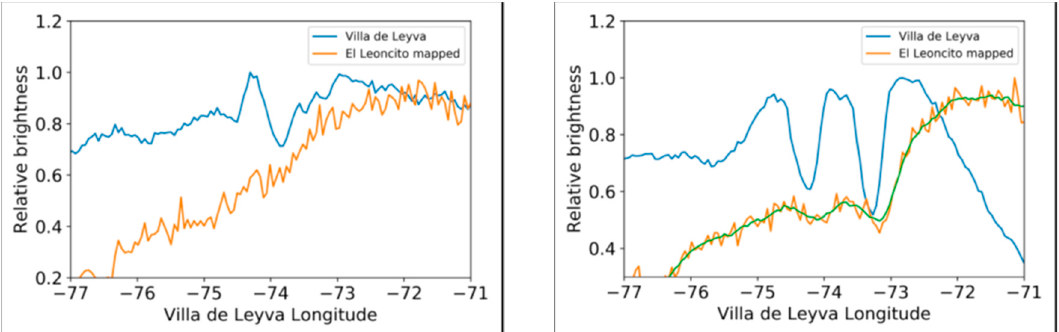
Figure 12. ( left ) Blue line represents the normalized brightness obtained from the cut at 9° N over the Villa de Leyva imager. The orange line is the brightness from the conjugate line at El Leoncito (the top red curve on the right image from Figure 11) mapped along magnetic field lines to the Villa de Leyva coordinate system; ( right ) Normalized brightness from the 7° N cut over Villa de Leyva (blue line). The orange line is the brightness from the conjugate line at El Leoncito (the bottom red curve on the right image from Figure 11). The green line is a running average of 7 pixels to make the depletions more clearly visible. Only the right panel shows that two depletions are visible at Villa de Leyva and El Leoncito between − 73° and − 75° longitudes.